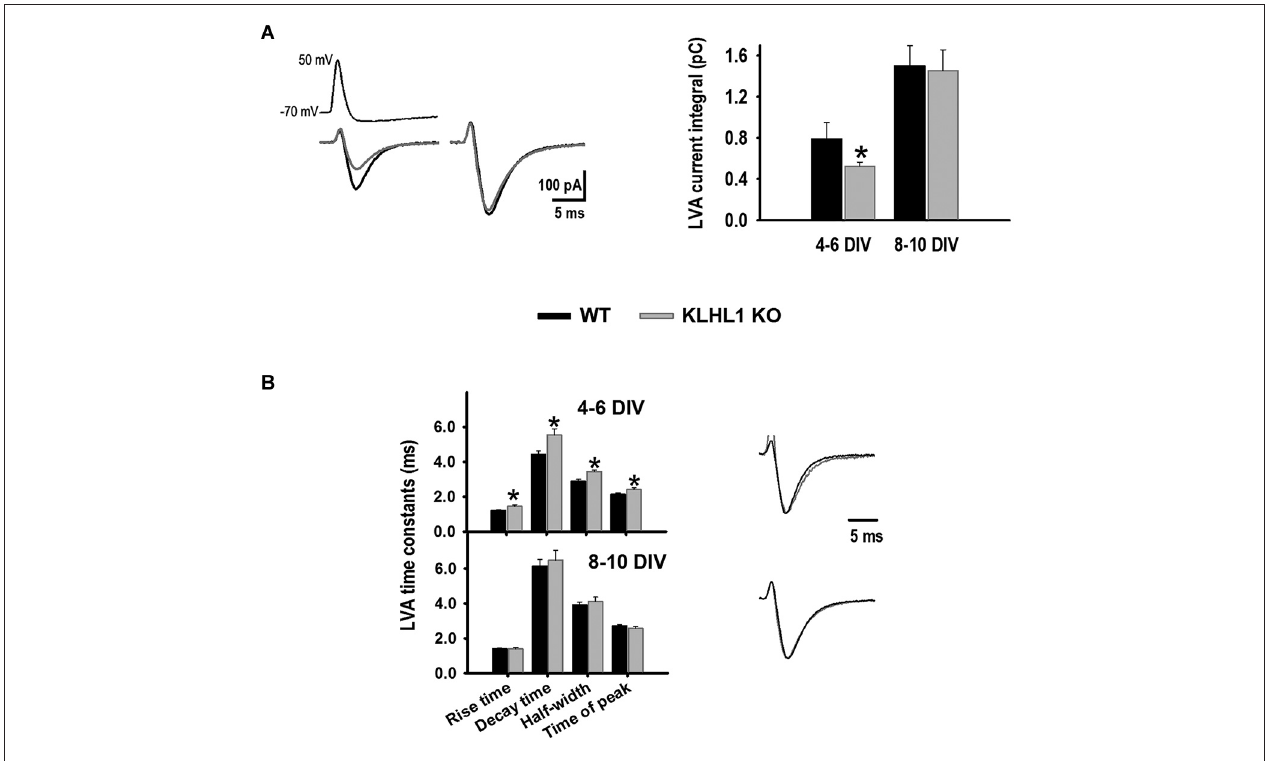
average current integral values are shown to the right ( n = 22, 34). (B) LVA current time constants (left) and normalized traces (right). * p < 0.05, Student’s t